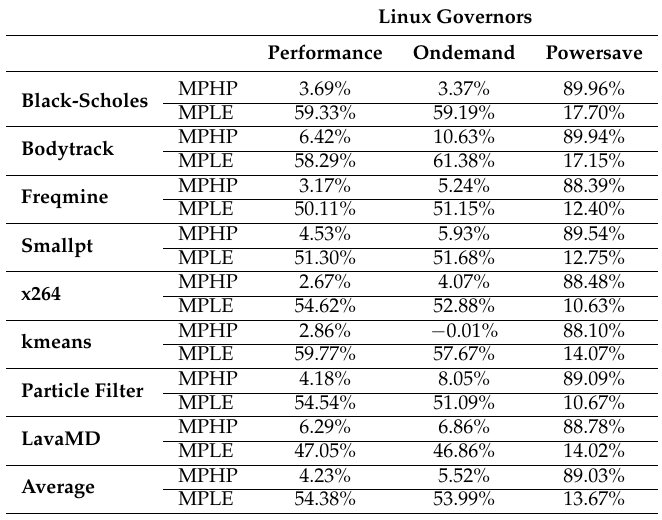
Table 6. Percentage of performance gains and energy savings when compared to the measured Pareto configurations that give the highest performance (MPHP) and the least energy consumption (MPLE), respectively, for all